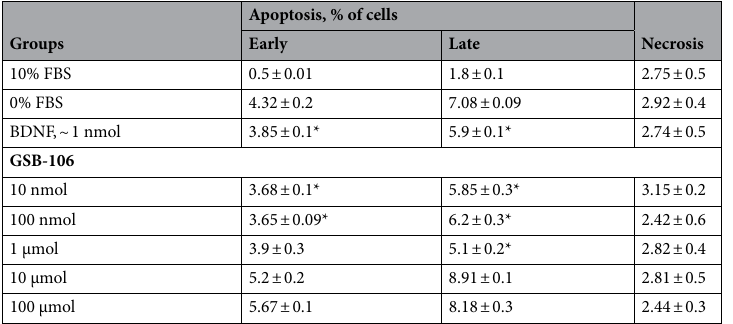
Table 1. GSB-106 attenuates the apoptosis of serum withdrawn SH-SY5Y cells. SH-SY5Y cells were cultured in serum-free culture medium (0% FBS) and treated with BDNF. (~ 1 nmol) or GSB-106 (10 nmol to 100 µmol) for 72 h. After incubation cells were collected and stained with Metabolic Activity Dead Cell Apoptosis Kit with C12 Resazurin, Annexin V APC, and SYTOX Green according to the manufacturer’s recommendations. The stages of apoptosis were determined by staining: early—Annexin V + /SYTO Green − ; late—Annexin V + / SYTO Green + ; necrosis—Annexin V − /SYTO Green + . The data is presented as the mean ± S.E.M. of percentage of total cell population (n = 3; *p < 0.05 compared with the “0% FBS” group; Wilcoxon t